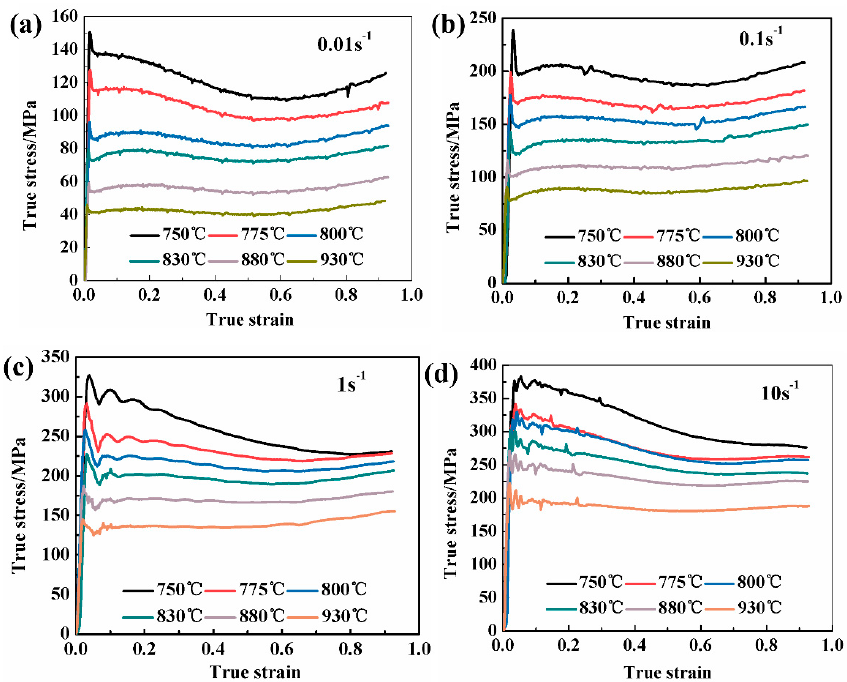
Figure 2. True stress–strain curves of Ti-35421 alloy at different strain rates ( a ) 0.01 s − 1 ; ( b ) 0.1 s − 1 ; ( c ) 1 s − 1 ; ( d ) 10 s − 1 .